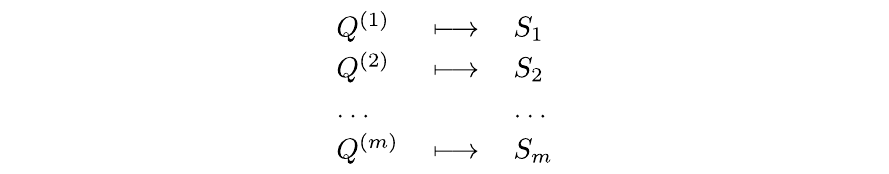
Fig. 2 Use of m realizations of an isomorphic question for individualized assessment of students S i , i = 1,..., m